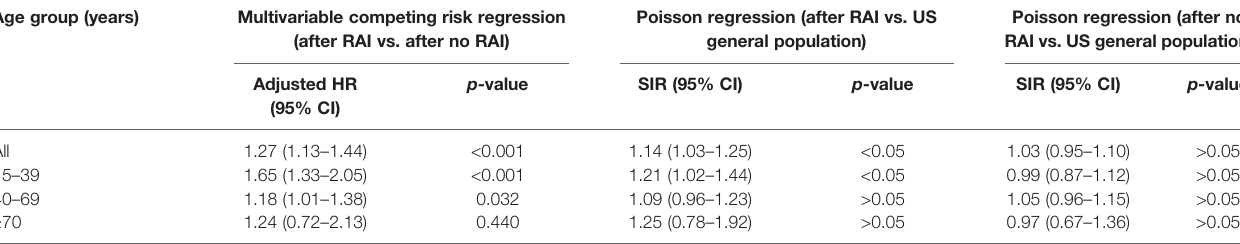
TABLE 2 | Risk of developing second breast cancer in female-differentiated thyroid cancer patients. Age group (years) Multivariable competing risk regression